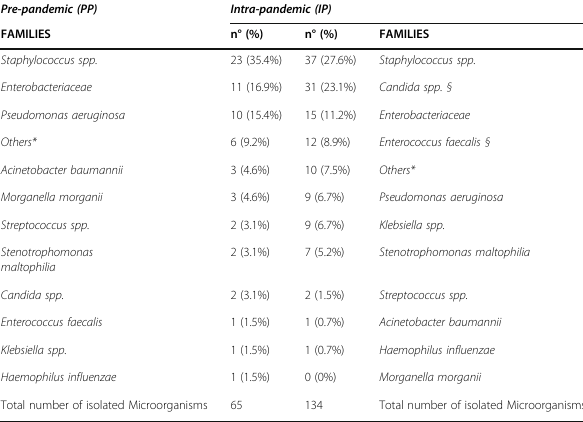
Table 2 (abstract A113). Microbial isolations in blood, respiratory tract and urinary tract